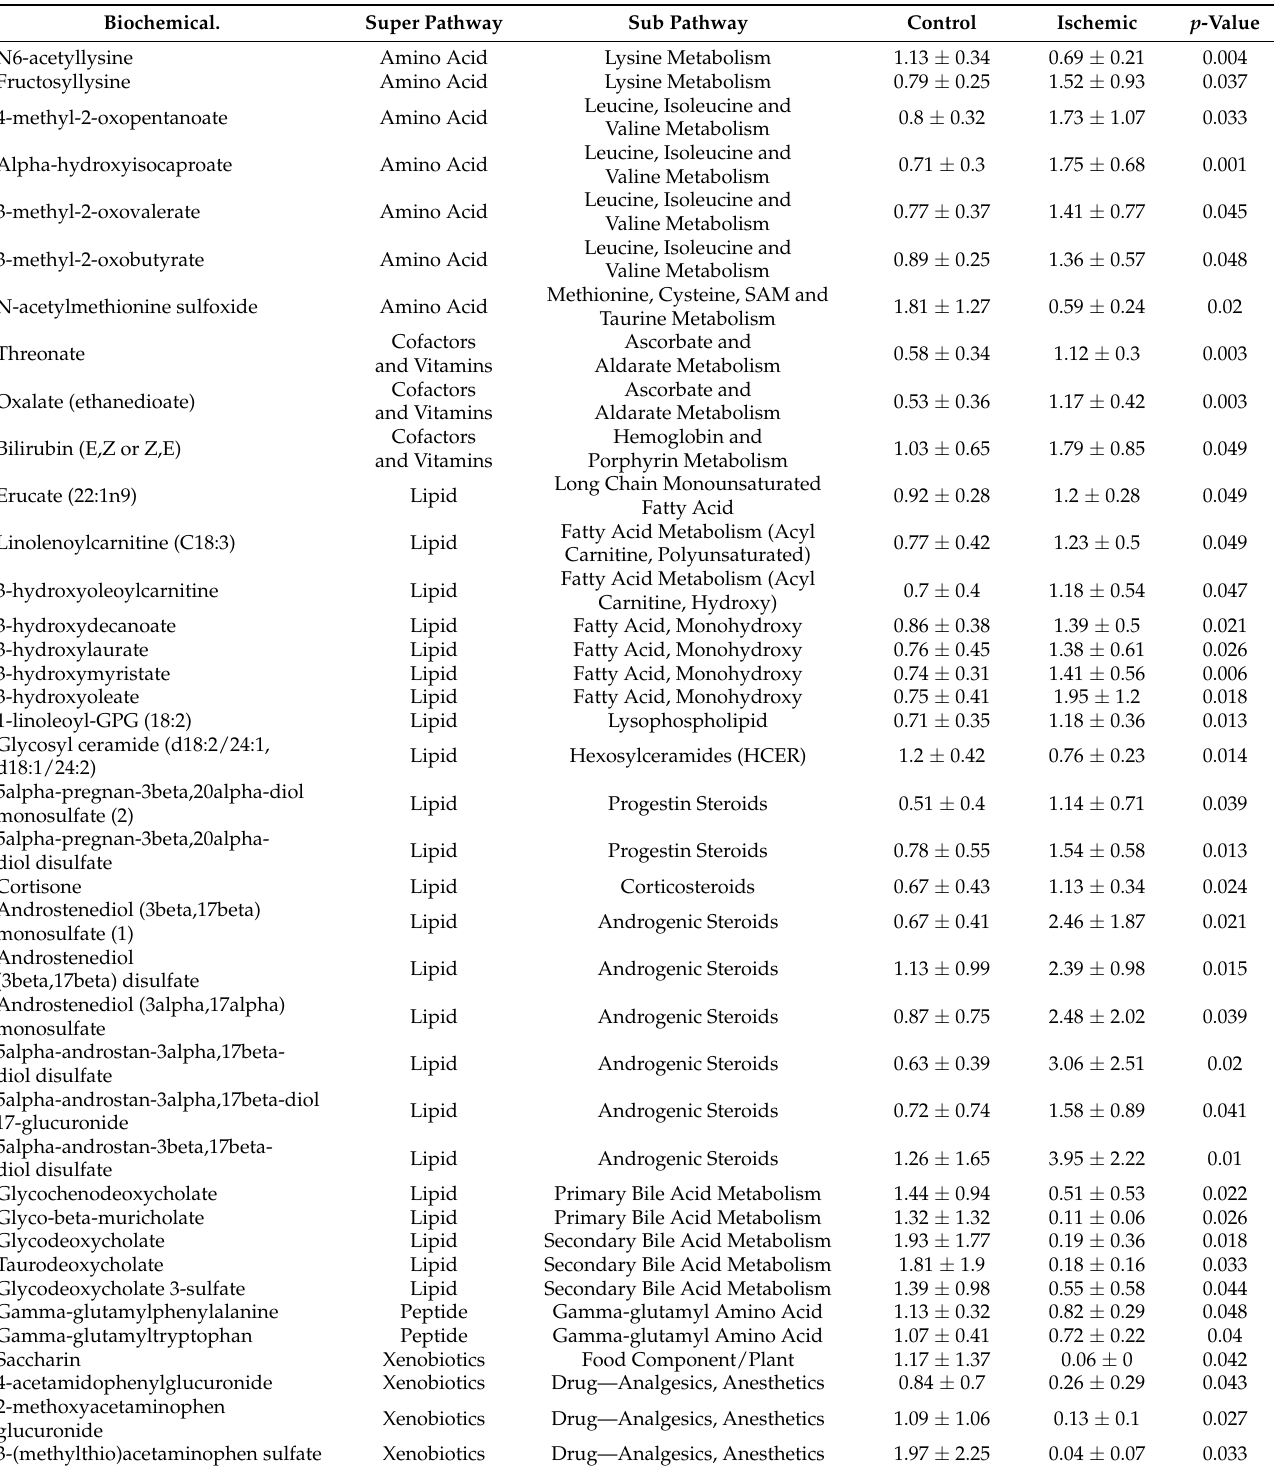
Table 3. Metabolite differences between ischemic stroke patients and control patients in the male population.